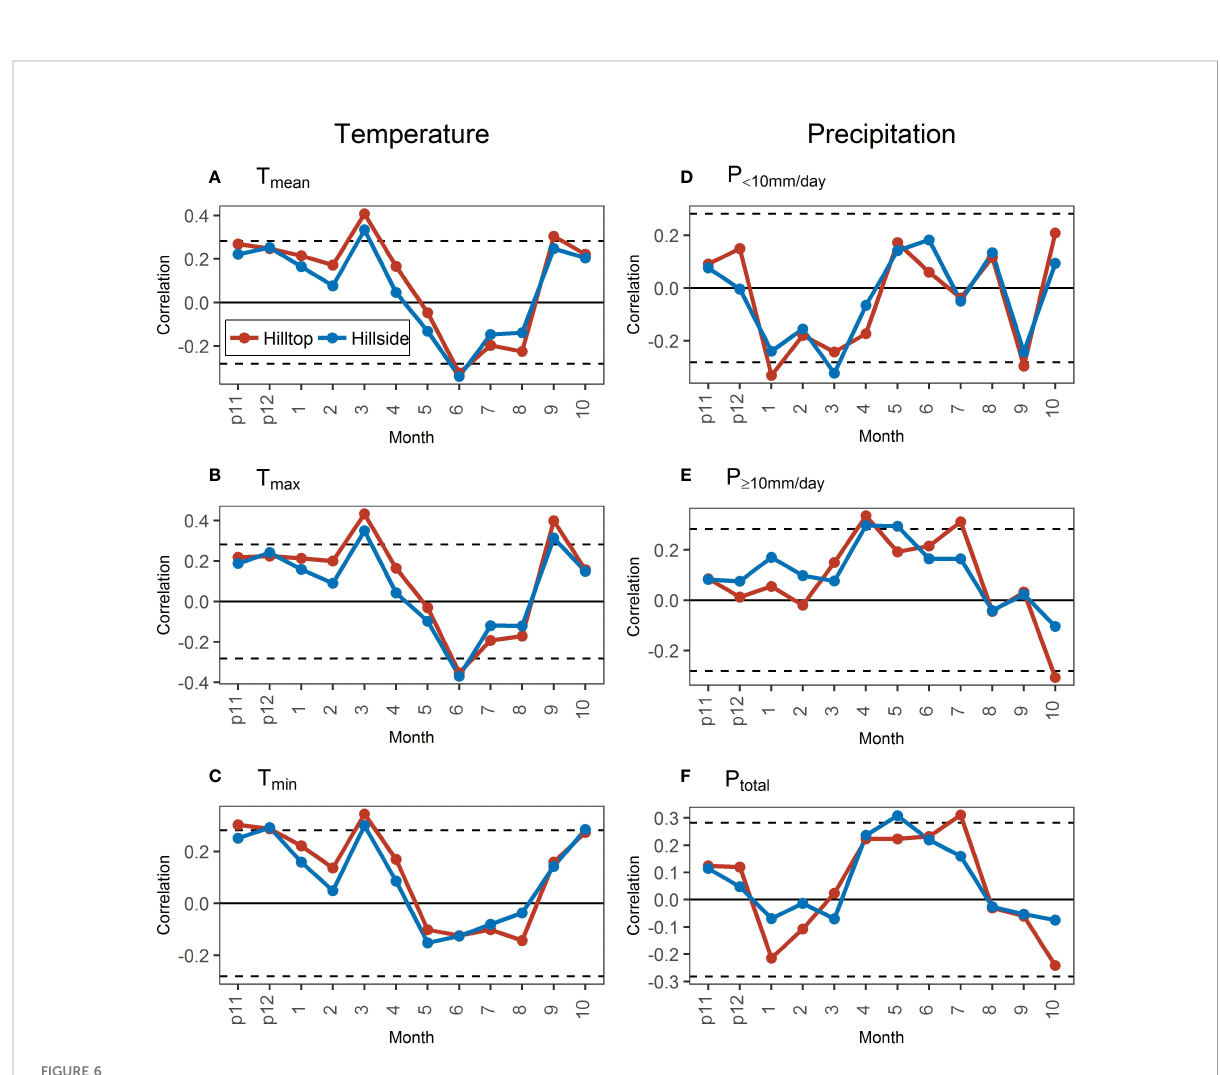
FIGURE 6 Correlations of standard chronologies (STDs) with monthly temperature (A – C) and precipitation (D – F) variables in the hilltop and the hillside during 1971 – 2020. The dotted black lines represent the signi fi cance level at 0.05. “ p11 ” and “ p12 ” represent November and December of the previous